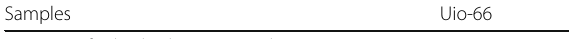
Table 2 The adsorption of eosin Y on various samples Samples